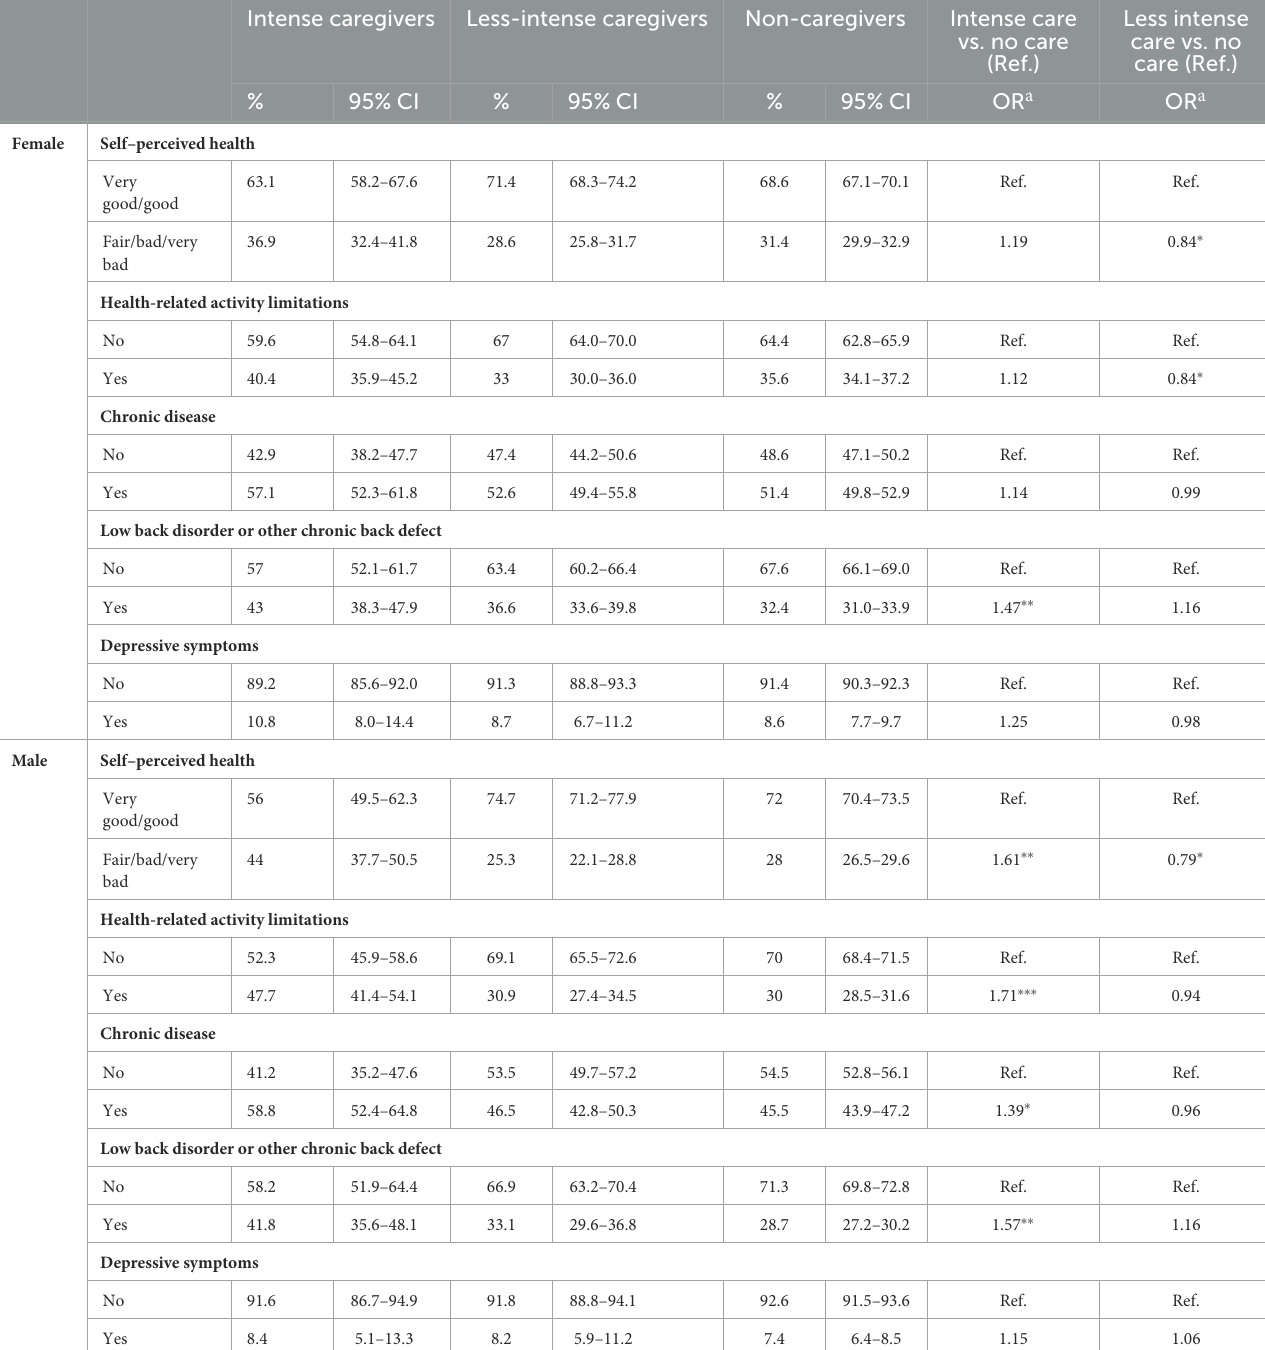
TABLE 3 Health status of caregivers and non–caregivers by gender (weighted analyses). Intense caregivers Less-intense caregivers Non-caregivers Intense care